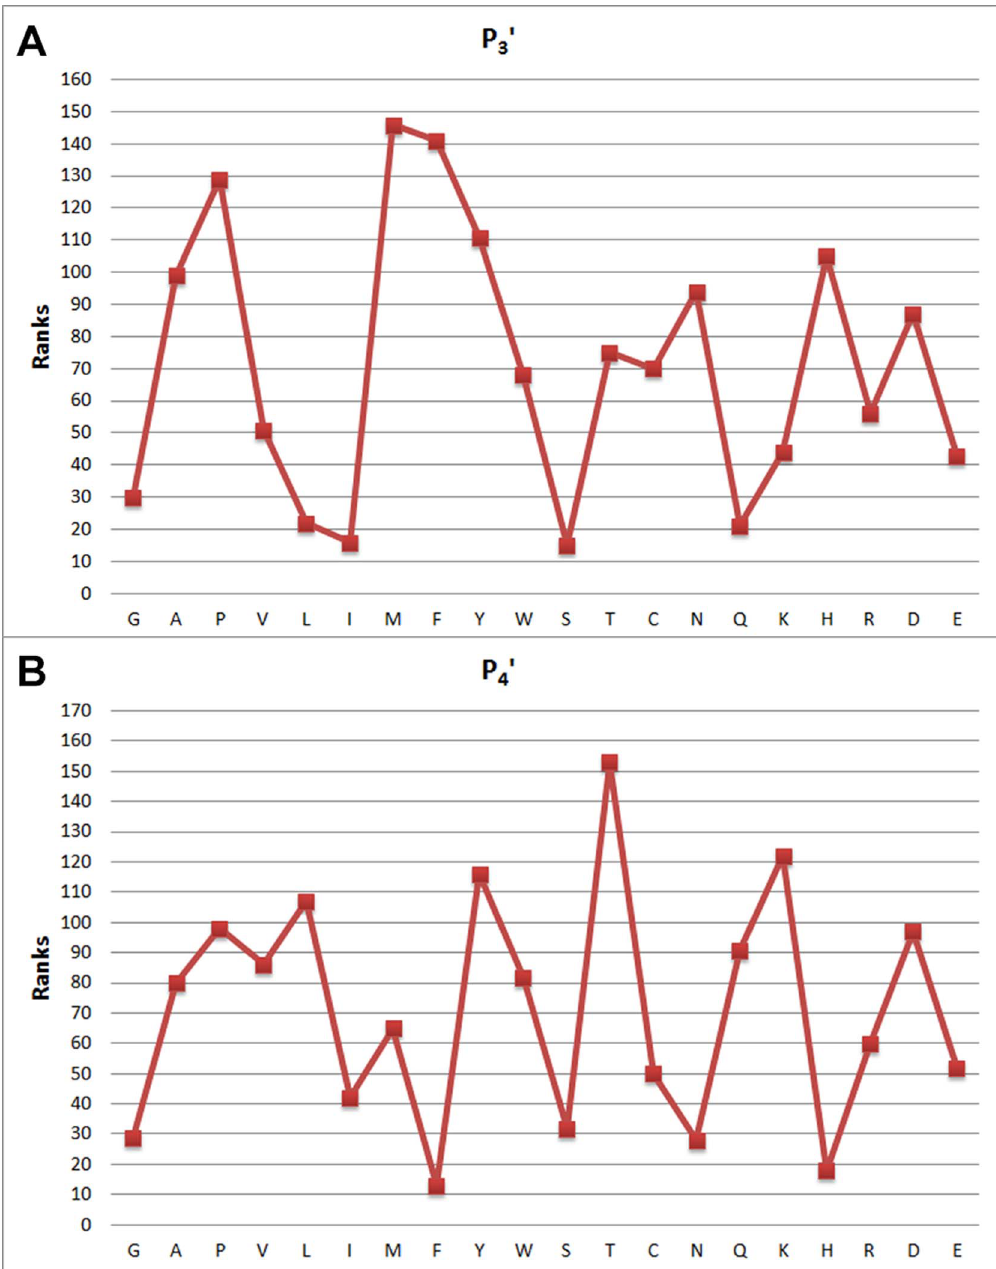
Figure 7. Feature weights of (a) P 3 ’ and (b) and P 4 ’: attribute values with respect to indices and the distribution of attribute weights.